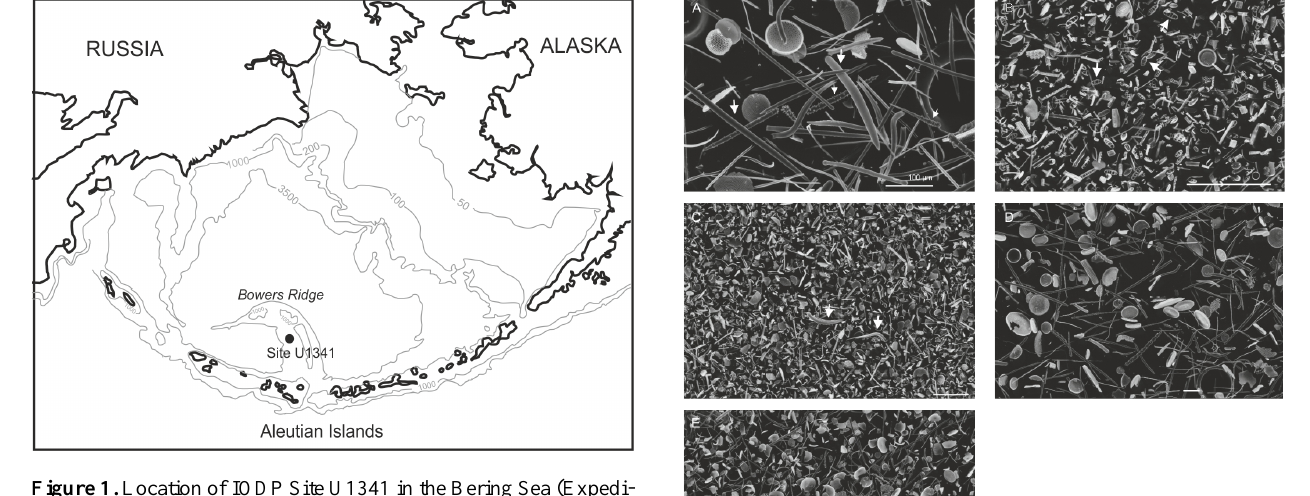
Figure 1. Location of IODP Site U1341 in the Bering Sea (Expedi- tion 323 Scientists, 2010).